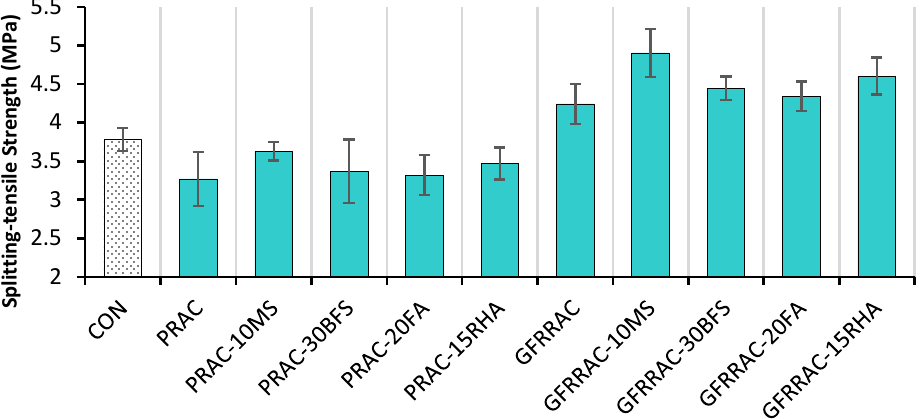
Figure 11. Effect of mineral admixtures and glass fibers on splitting tensile strength (f SP ) of RAC.